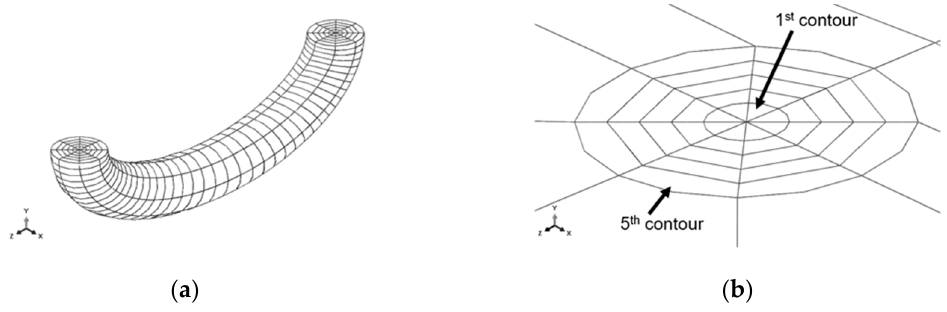
Figure 5. ( a ) Mesh details around crack front; ( b ) mesh contours around crack front. Table 3. Information regarding each numerical model that